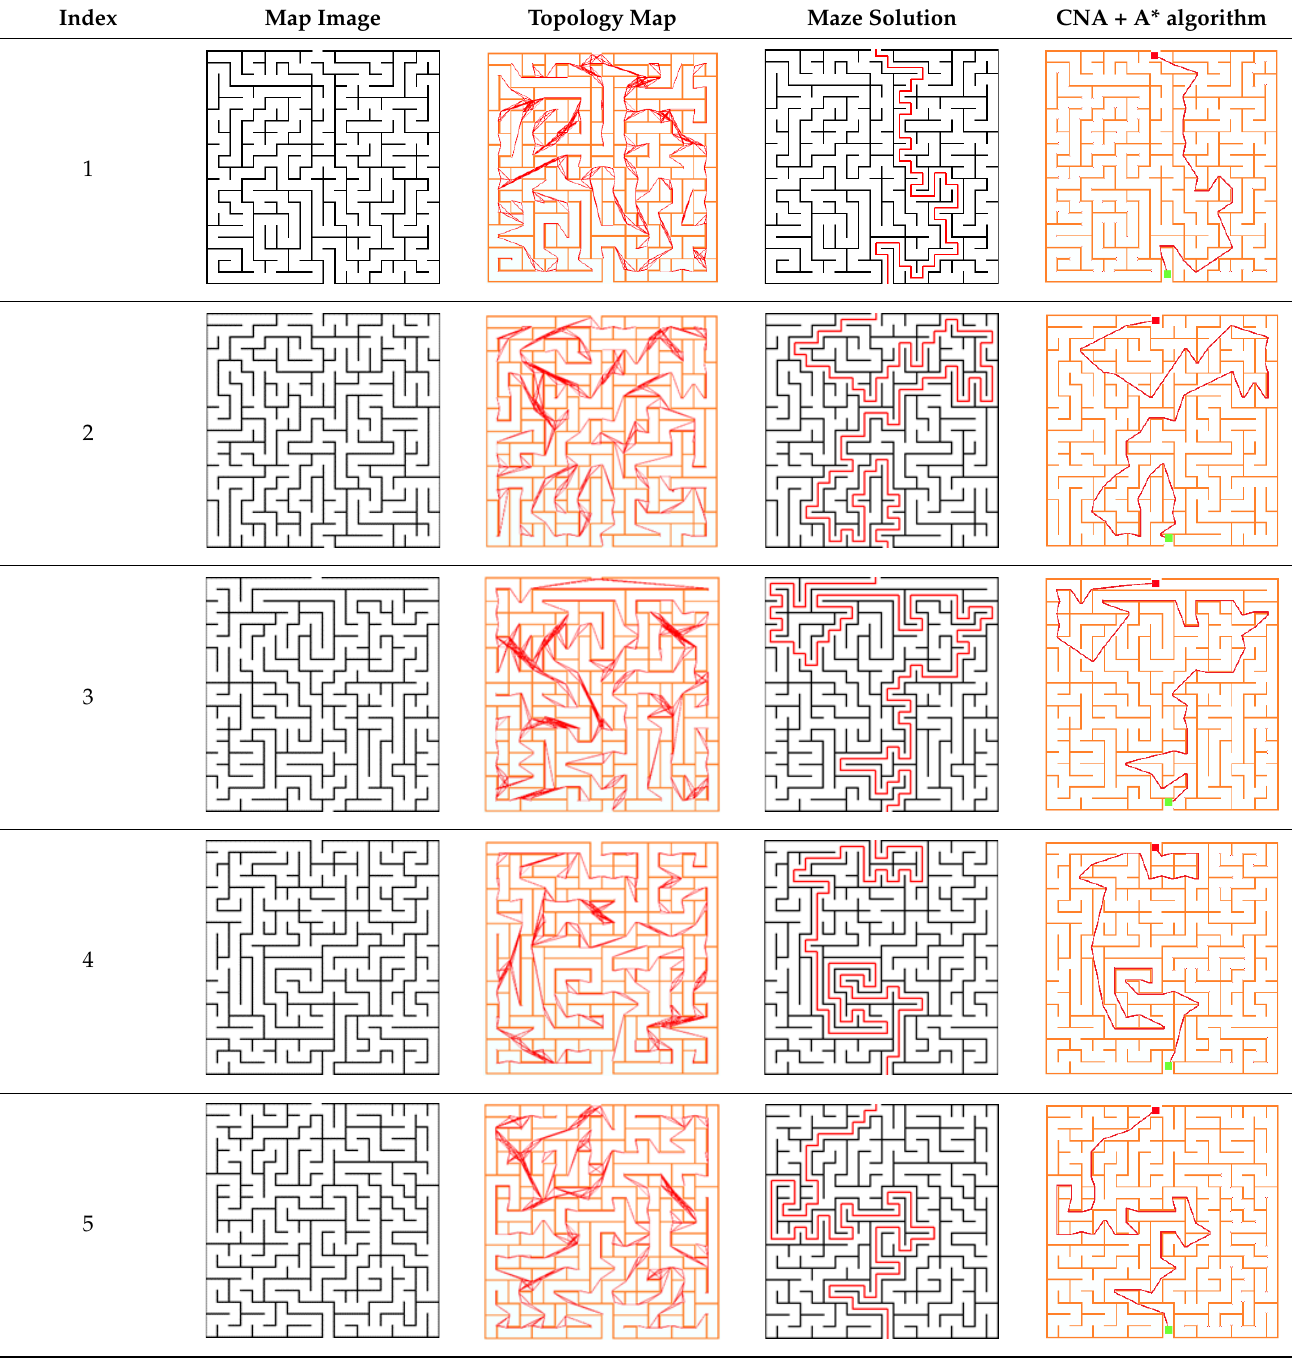
Table 3. Experimental results.